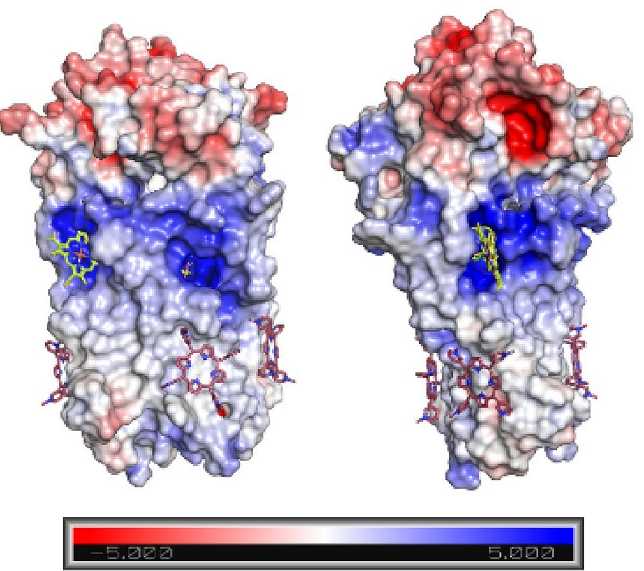
Figure 7. Structures of ORF3a complexes with ClFePP (green) and Chlorin (pink) according to the results of molecular